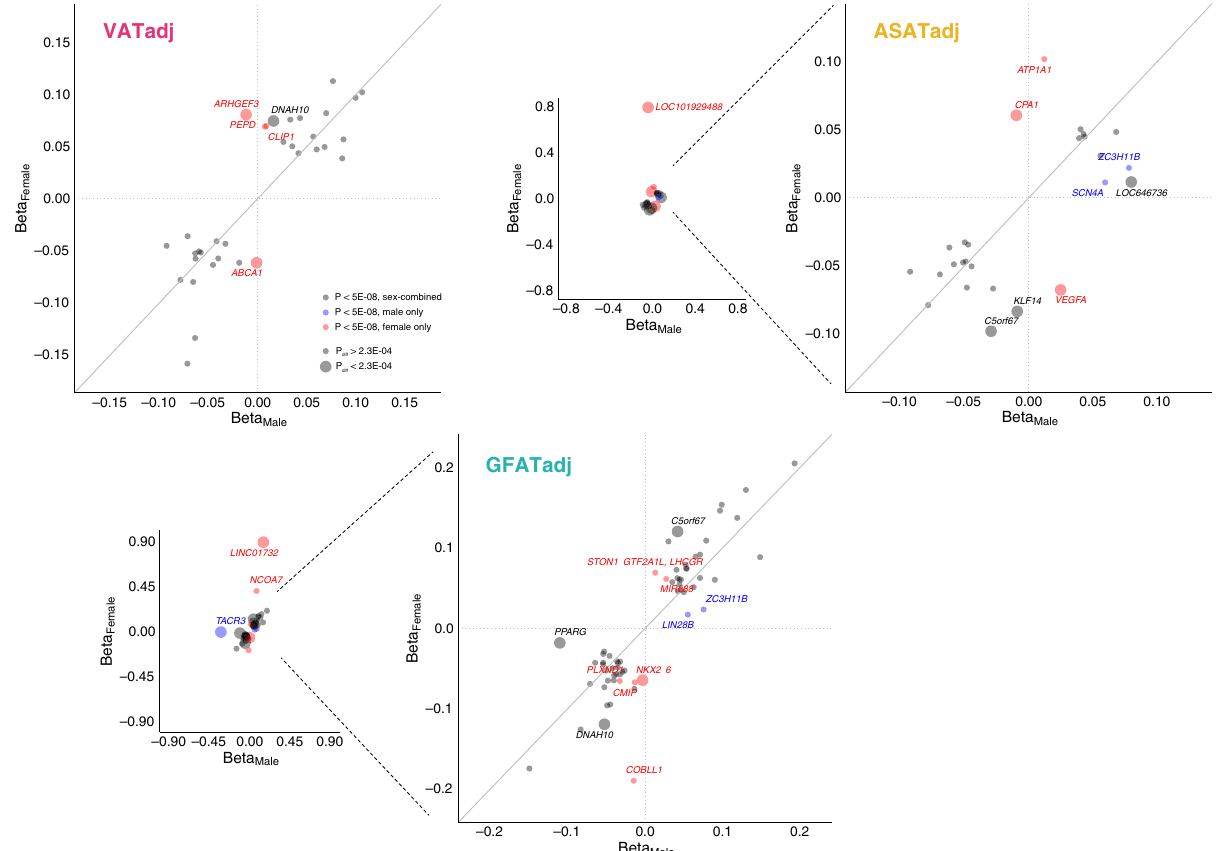
Fig. 3 Common variant sex heterogeneity for VATadj, ASATadj, and GFATadj local adiposity traits. For each adiposity trait, independent loci that were associated with the trait in either sex-combined or sex-strati fi ed analyses are plotted (Supplementary Data 10). Thirty-four such loci are plotted for VATadj, 27 for ASATadj, and 65 for GFATadj. Loci colored black were genome-wide signi fi cant ( p < 5 × 10 − 8 ) in sex-combined analysis, blue loci were signi fi cant for males, but neither females nor sex-combined, and red loci were signi fi cant for females, but neither males nor sex-combined. p diff corresponds to the “ calcpdiff ” function in EasyStrata comparing SNP effects in males and females (Methods). Across six adiposity traits (VATadj, ASATadj, GFATadj, VAT/ASAT, VAT/GFAT, and ASAT/GFAT), 220 unique loci-trait pairs were tested for sex heterogeneity (Supplementary Fig. 15), so a Bonferroni- corrected signi fi cance threshold of p diff < 0.05/220 = 2.3 × 10 − 4 was